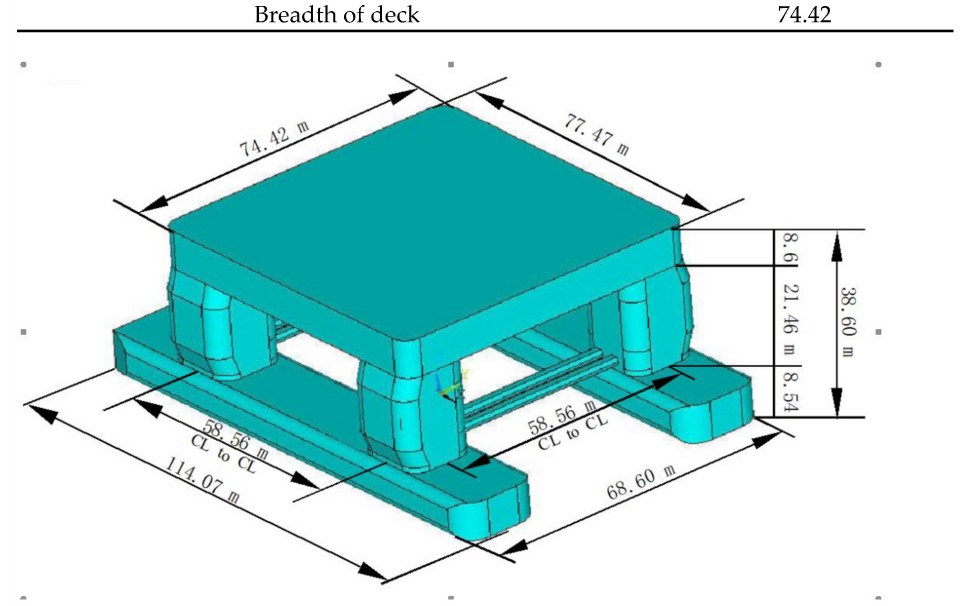
Figure 3. Configuration of the object